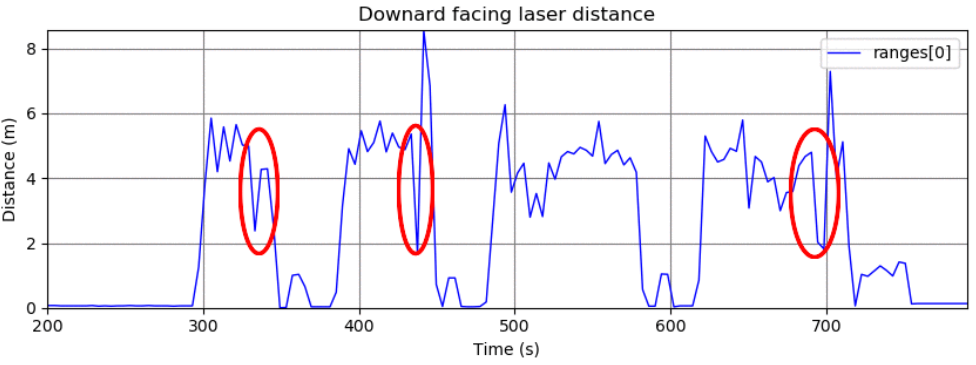
Figure 3. Plot of laser distance measurements during a flight in our trials. The passing vehicle is detected in several moments, indicated by the red ellipses. Detection by this laser fails in the third trial due to vehicle misalignment with the laser